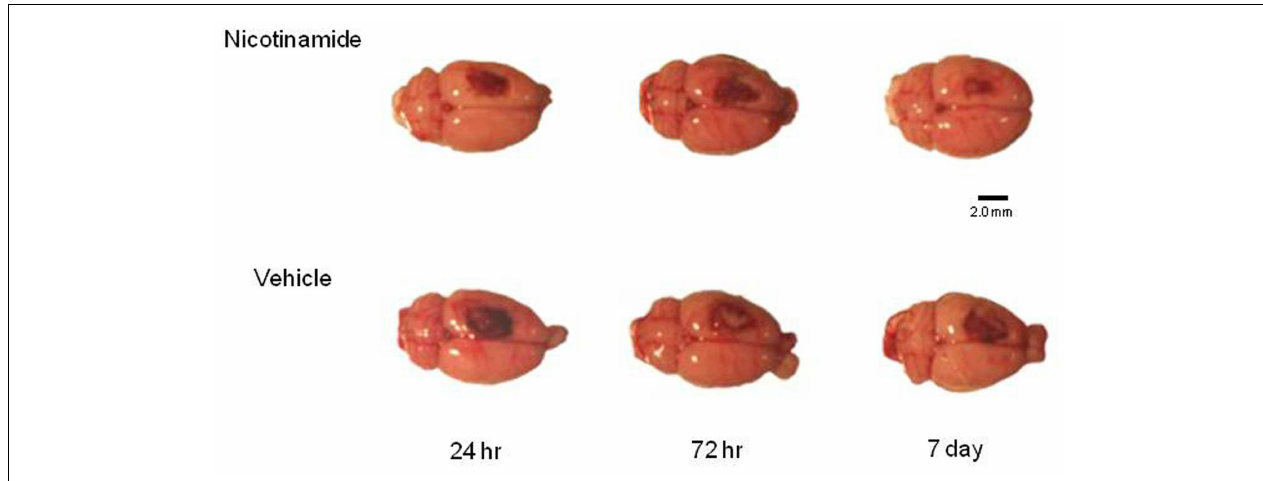
FIGURE 1 | Histology plate. Shown are representative dorsal images of the injury in each group prior to the harvesting of the tissue for analysis. Image bar is 2.0mm.